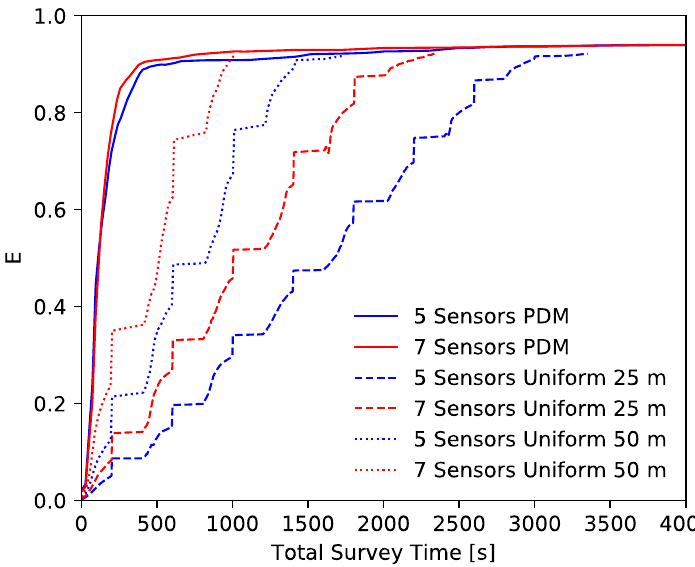
Figure 9. Direct comparison of the PDM-based survey routine results versus the uniform survey results as a function of the total survey time. The uncertainty in E for the GPR-predicted maps is represented by the prediction uncertainties shown in Figure 8.